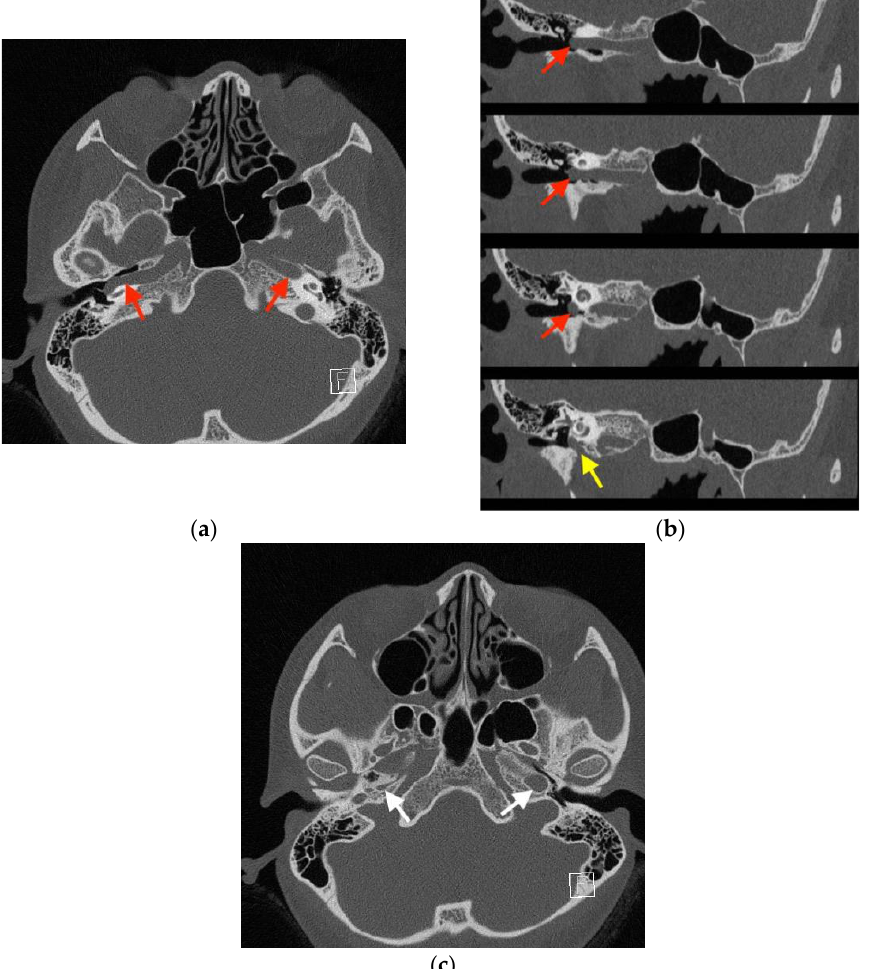
Figure 3. High-resolution computed tomography (HRCT) of the temporal bone, indicating a diagnosis of right aberrant internal carotid artery in the middle ear (aICA). ( a ) In the axial view, HRCT revealed a normal left internal carotid artery (ICA) (red arrow on the patient’s left) and lateral bulging of the right ICA to the right of the tympanic cavity without a bony covering (red arrow on the patient’s right). ( b ) The oblique view demonstrated the lateral bulging of the right ICA to the right of the tympanic cavity (red arrows) and the enlarged right inferior tympanic canaliculus (yellow arrow) through which the aICA (inferior tympanic artery portion) passes. ( c ) In the axial view, a normal left carotid canal (white arrow on the patient’s left) and a hypoplastic carotid canal (white arrow on the patient’s right) were observed. The aforementioned findings from HRCT indicated a diagnosis of right